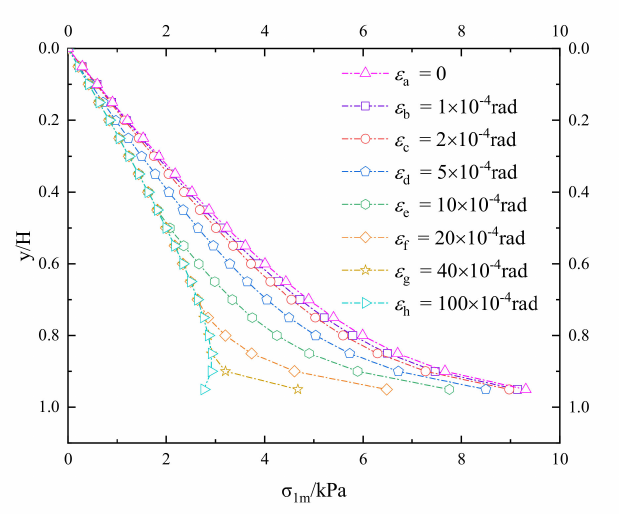
Figure 5. Horizontal active earth pressure distribution along wall depth with varying rotation angle.